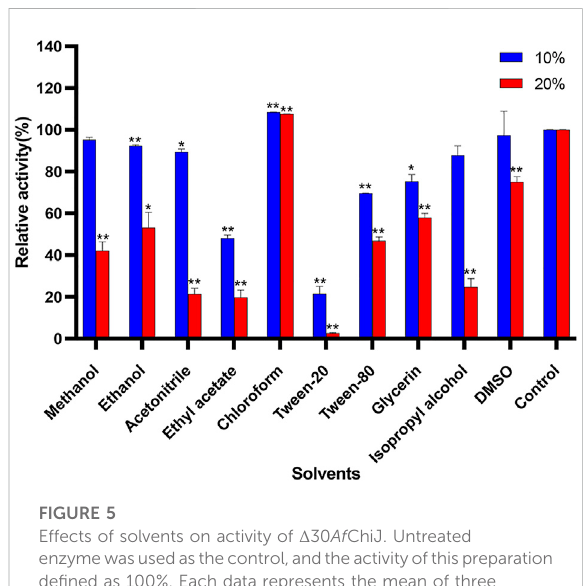
FIGURE 5 Effects of solvents on activity of Δ 30 Af ChiJ. Untreated enzymewasusedasthecontrol,andtheactivityofthispreparation de fi ned as 100%. Each data represents the mean of three independent experiments, standard errors are shown (mean ± SD). Asterisks indicate statistically signi fi cant difference, compared with the control (Student ’ s t-test. *, p < 0.05; **, p < 0.01). Abbreviation: DMSO, dimethylsulfoxide.